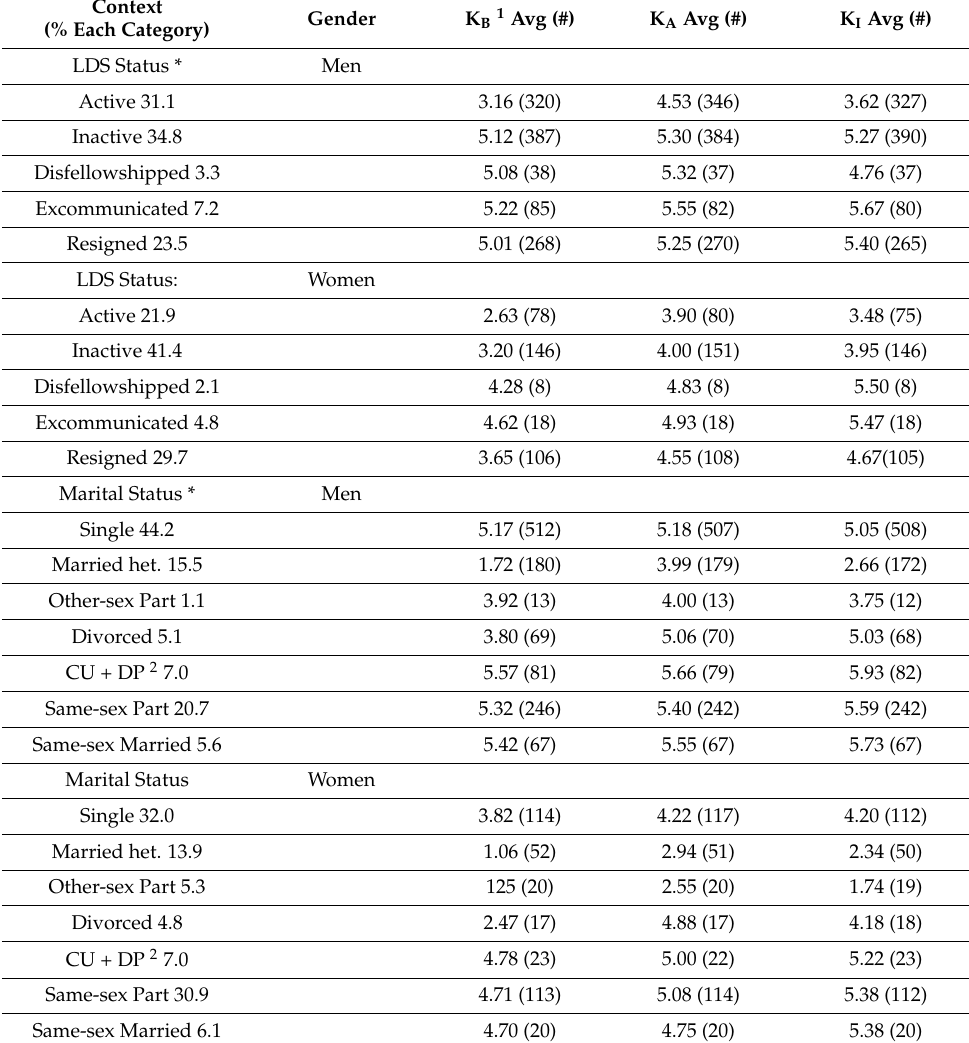
Table 4. Gender Comparison of Kinsey Scale Scores by LDS and Marital